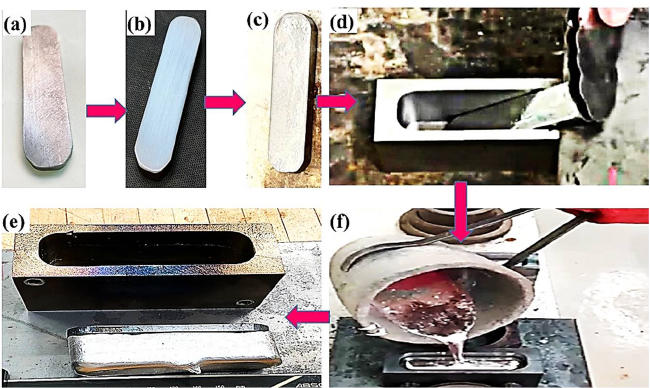
Figure 1. Aluminum/steel bimetal casting: ( a ) steel substrate after cutting; ( b ) steel substrate after grinding; ( c ) steel substrate after tinning; ( d ) tinned steel substrate was inserted into the metallic mold; ( e ) fabricated bimetallic casting; ( f ) molten Al alloy was poured into the metallic mold. Table 3. Pre-tinning interlayer and processing conditions of the steel solid substrate and Al-bearing alloy for six specimens .